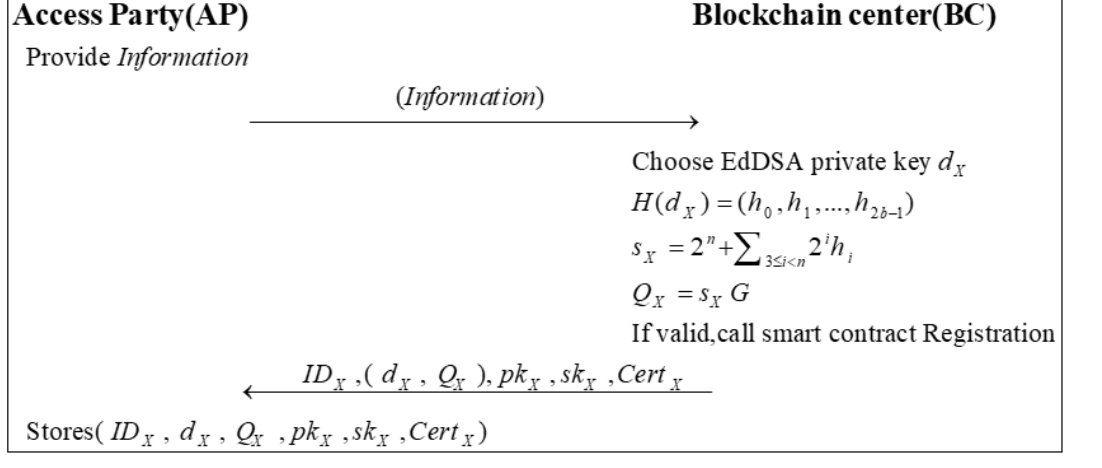
Figure 4. The process of the registration phase.